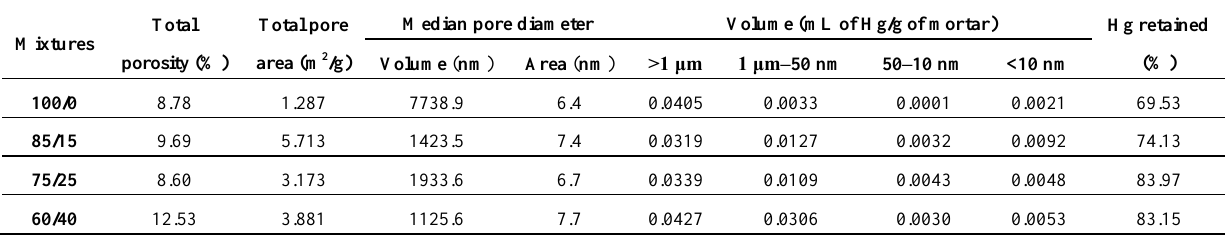
Table 6. MIP results for pastes cured after 270 days at 20